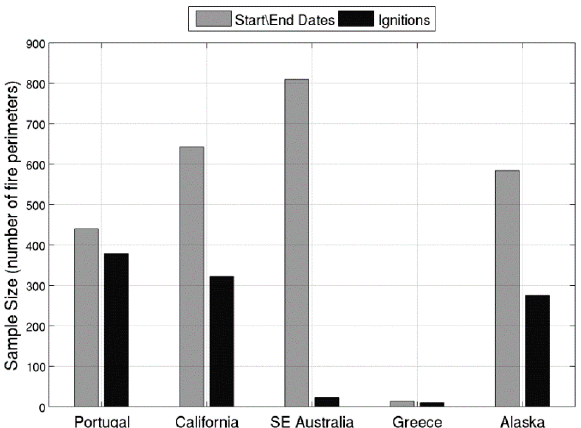
Figure 3. Evaluation sample size for the five study regions, regarding the total number of wildfire perimeters with reported start/end dates ( N = 2491) and reported ignitions ( N = 1010).